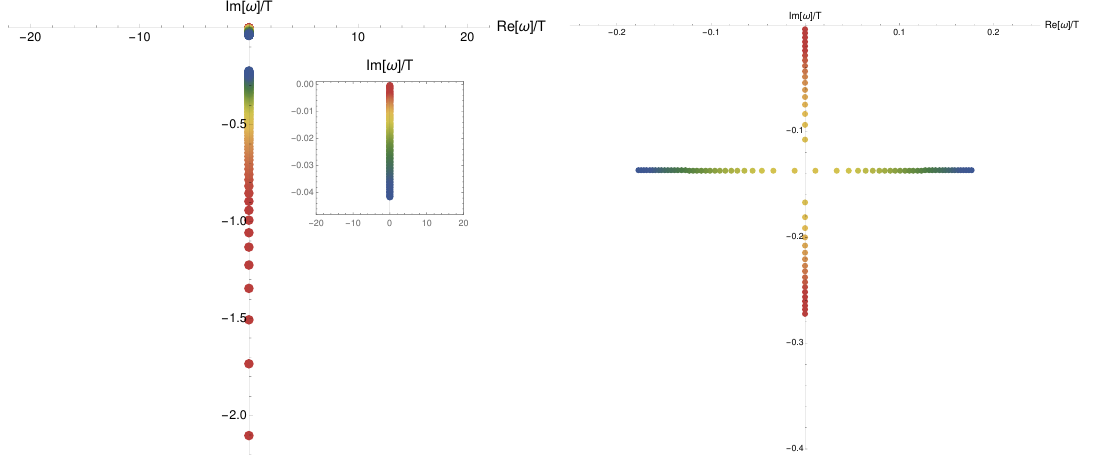
Figure 10 . A sketch of Quasi-normal mode spectrum for transverse (cid:13)uctuations as a function of the ratio between explicit and spontaneous breaking scales. Left: whenever the spontaneous breaking is negligible, i.e. for (cid:12) (cid:28) 1, the (cid:22)(cid:10) pole is not an hydrodynamic pole. The only hydrodynamic pole is the Drude pole (if the explicit breaking scale is small, i.e. m=T (cid:28) 1). Center: in the pseudo- spontaneous case, i.e. for (cid:12) (cid:29) 1, both the Drude and the (cid:22)(cid:10) poles have small frequency and the expression (6.10) holds. Right: in the purely spontaneous case, i.e. for (cid:12) = 1 , the Drude and (cid:22)(cid:10) poles collapse into the origin of the complex frequency plane and they produce the double pole identi(cid:12)ed as the massless phonon.